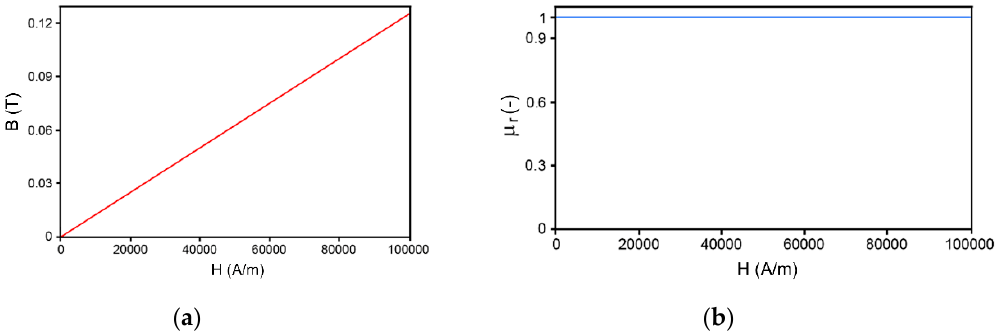
Figure 2. Typical B/H characteristics for paramagnetic material (i.e., tungsten) ( a ); permeability characteristics for paramagnetic material (i.e., tungsten) ( b ).